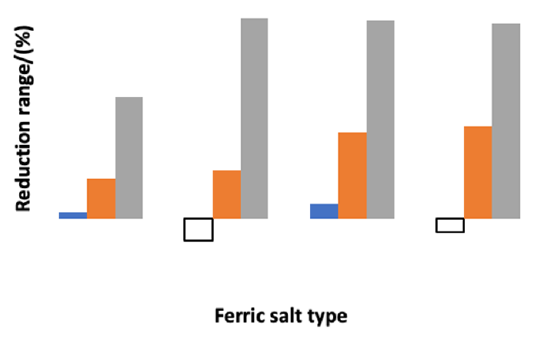
Fig. 4 Treatment results of effluent from aeration tank with different valence ferric